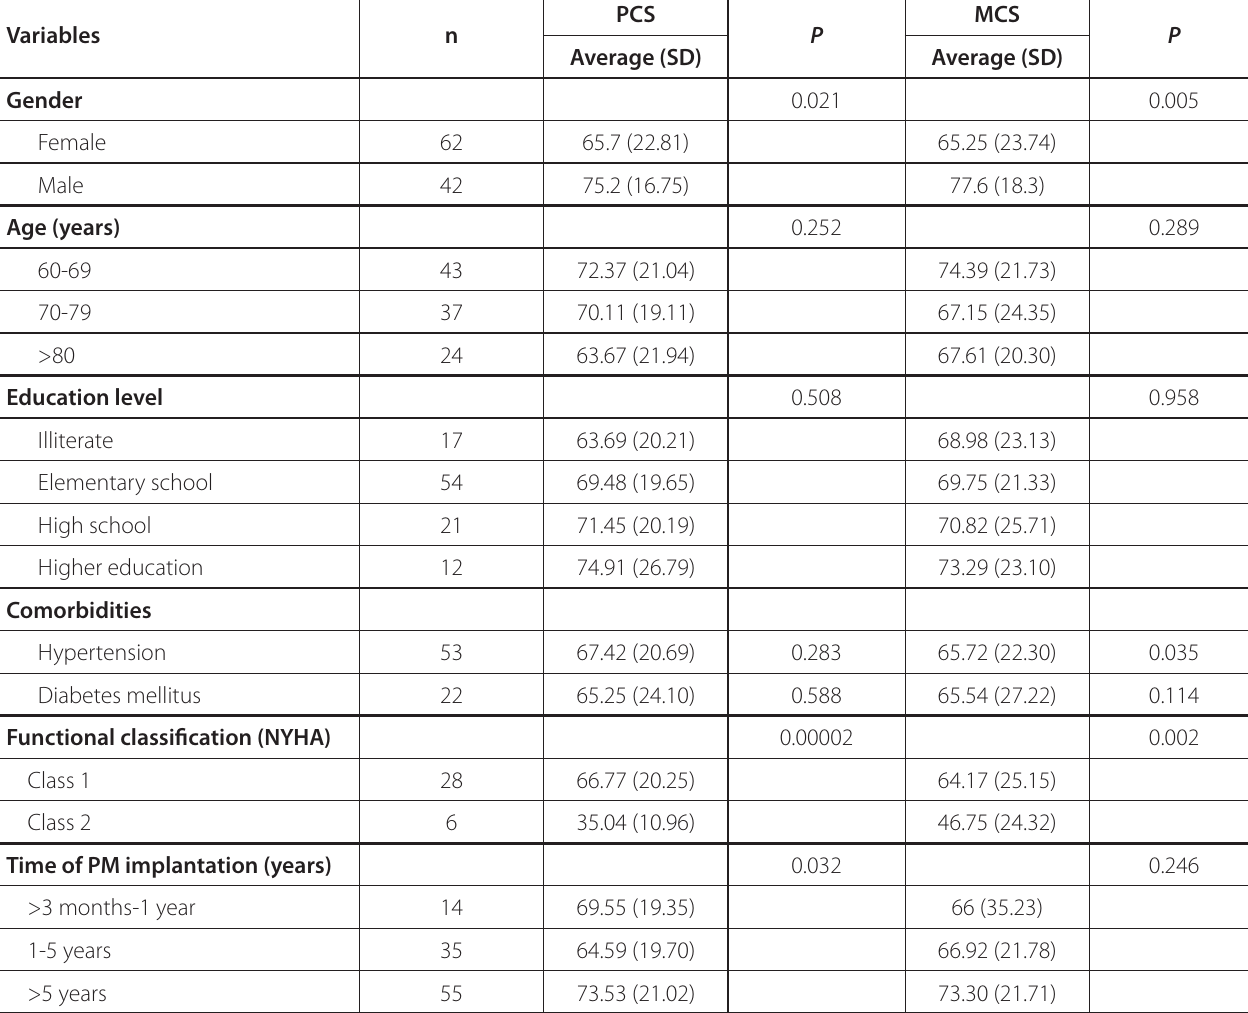
Table 6 . Average SF-36 physical (PCS) and mental (MCS) scores according to demographic variables for elderly patients with a pacemaker (PM).